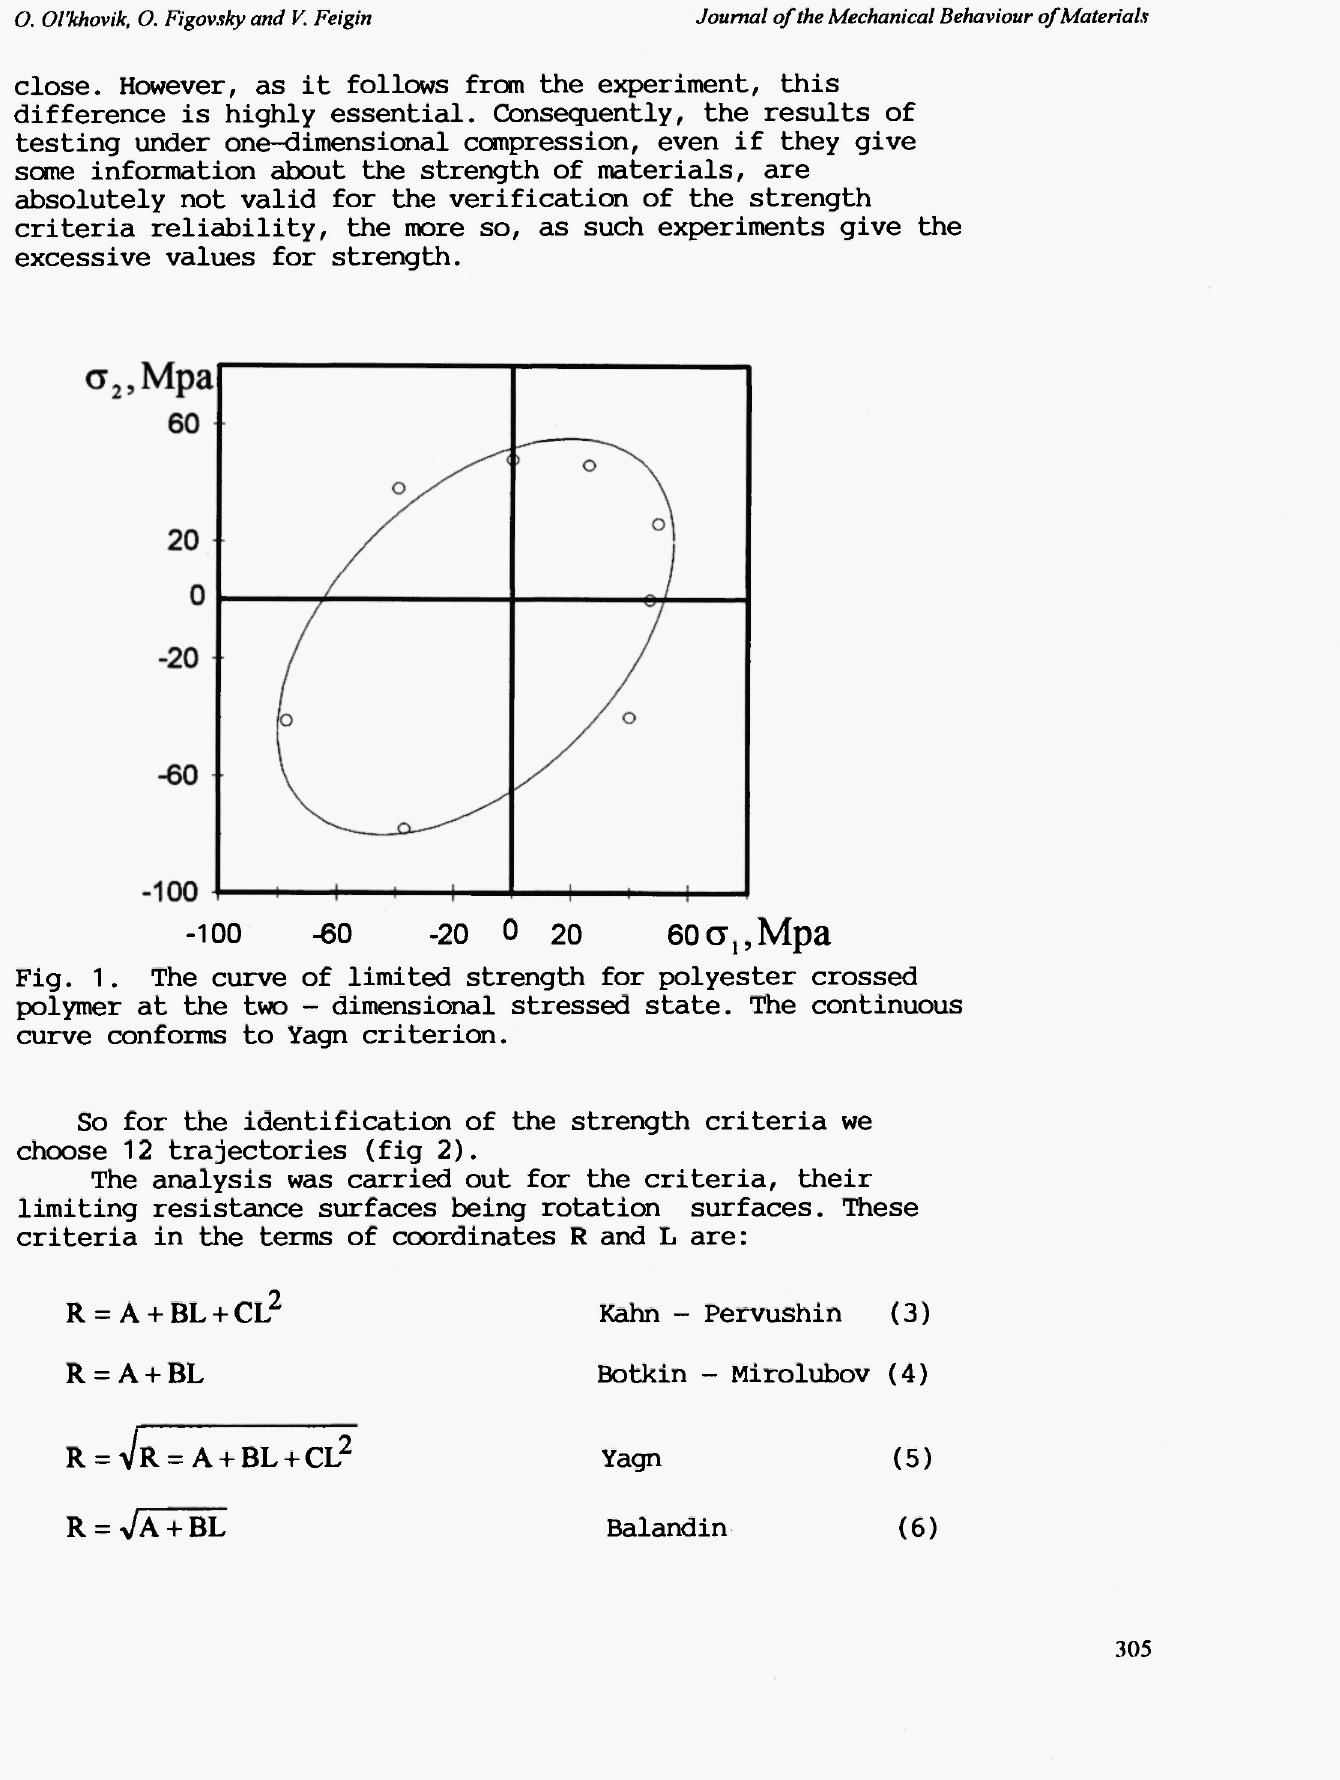
The curve of limited strength for polyester